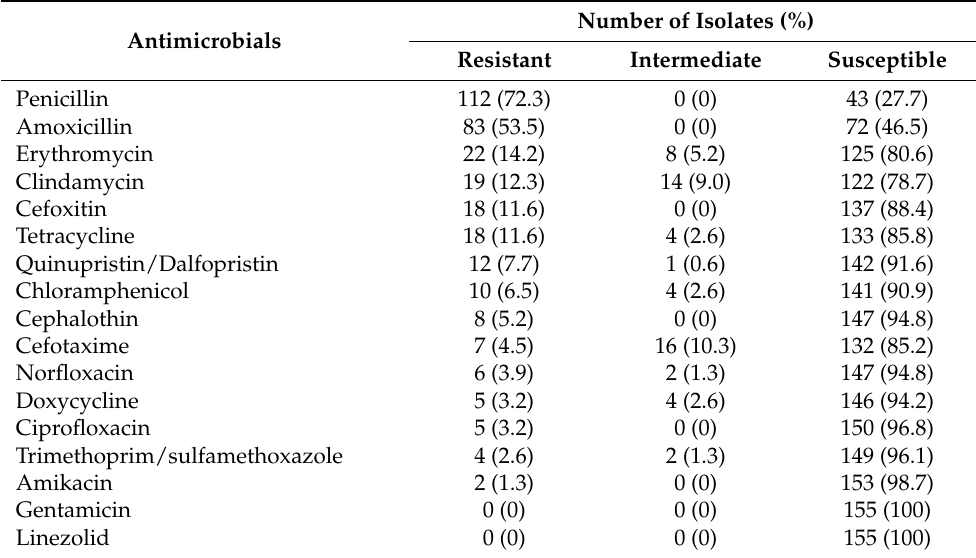
Table 2. Antibiogram of S. aureus ( n = 155) isolated from animal handlers in Peninsular Malaysia. Number of Isolates (%) Antimicrobials Resistant Intermediate